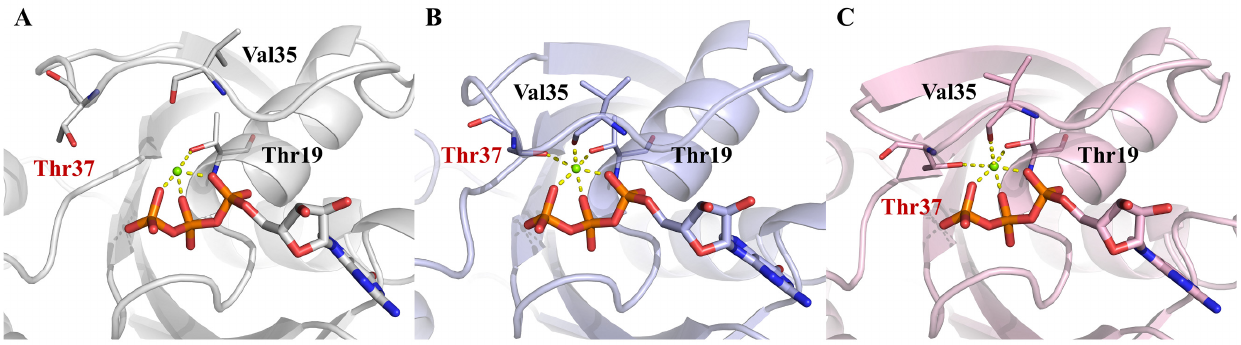
Figure 6. The coordination of Mg 2+ ion (green ball) in RhoA WT -GTP ( A , gray), RhoA G14V -GTP ( B , light blue), and RhoA Q63L -GTP ( C , light pink). The coordination interactions are indicated by dotted lines, and the residues involved are labeled and shown as sticks (colored by element).